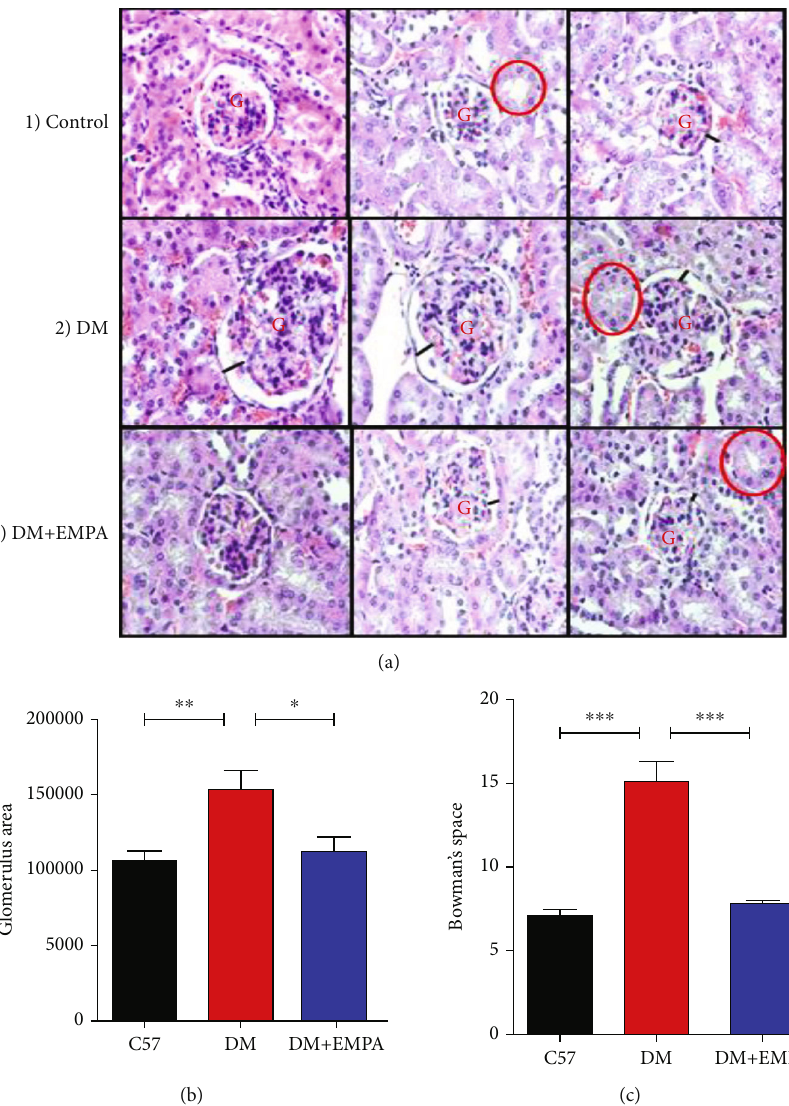
Figure 2: (a) Morphological H&E staining of kidney sections. A1. Representative H&E staining of healthy mice presents intact kidney morphology manifested with normal glomerulus size (red G), proximal convolute tubule (red circle), and Bowman ’ s capsular space (black line). A2. Enlargement of glomerulus size and relatively wider Bowman ’ s capsular space shown in representative morphology staining of DM mice. A3. Representative staining of DM+ EMPA presents reduced glomerulus size and relatively narrow Bowman ’ s capsular space and thicker Bowman membrane. (b) Total analysis quantitative measurement of glomerular size in the three groups and (c) Bowman ’ s capsule space size summary in the three